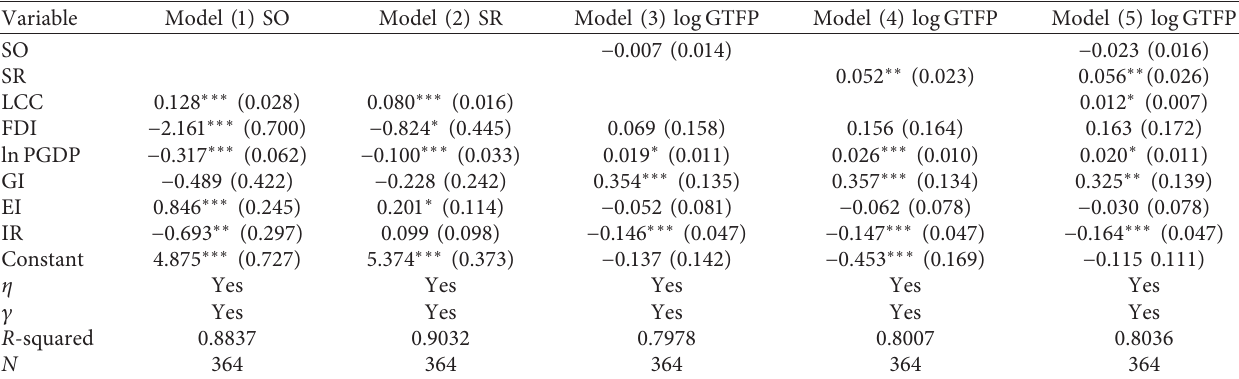
Table 6: The intermediary mechanism of industrial